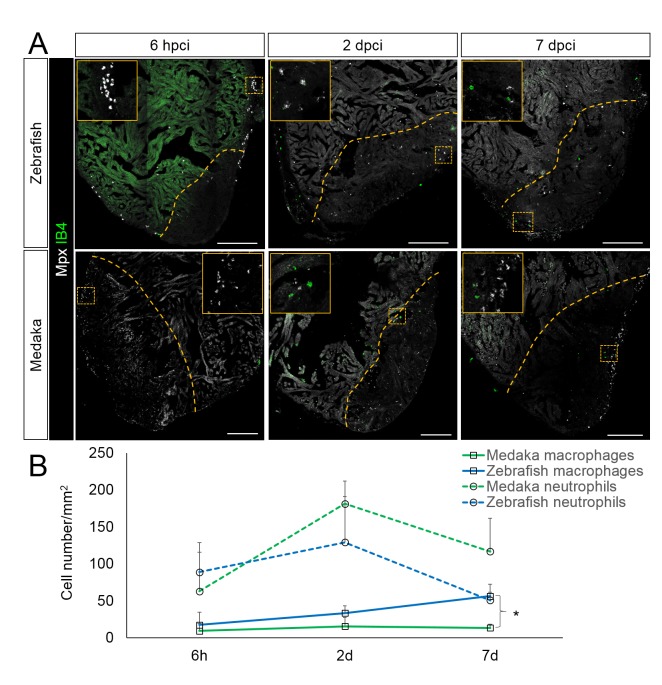
Immune cells dynamics in cryoinjured hearts.(A) Zebrafish and medaka heart sections at 6 hpci, 2 dpci and 7 dpci were stained with isolectin-B4 (IB4) for macrophages, and Mpx antibody for neutrophils. Positive cells, both in the injured area itself and within 100 μm of the injured area, were quantified (B; n = 3). Dotted lines delineate the injured area; scale bars, 200 μm. Macrophage numbers in medaka were always lower than those in zebrafish and this difference was especially pronounced at 7 pd. Neutrophil numbers appeared similar at 6 hpci, were higher in medaka at 2 dpci, and their clearance was delayed in medaka compared to zebrafish.DOI:
http://dx.doi.org/10.7554/eLife.25605.00510.7554/eLife.25605.006Figure 3—source data 1.Quantification of immune cells in cryoinjured hearts.